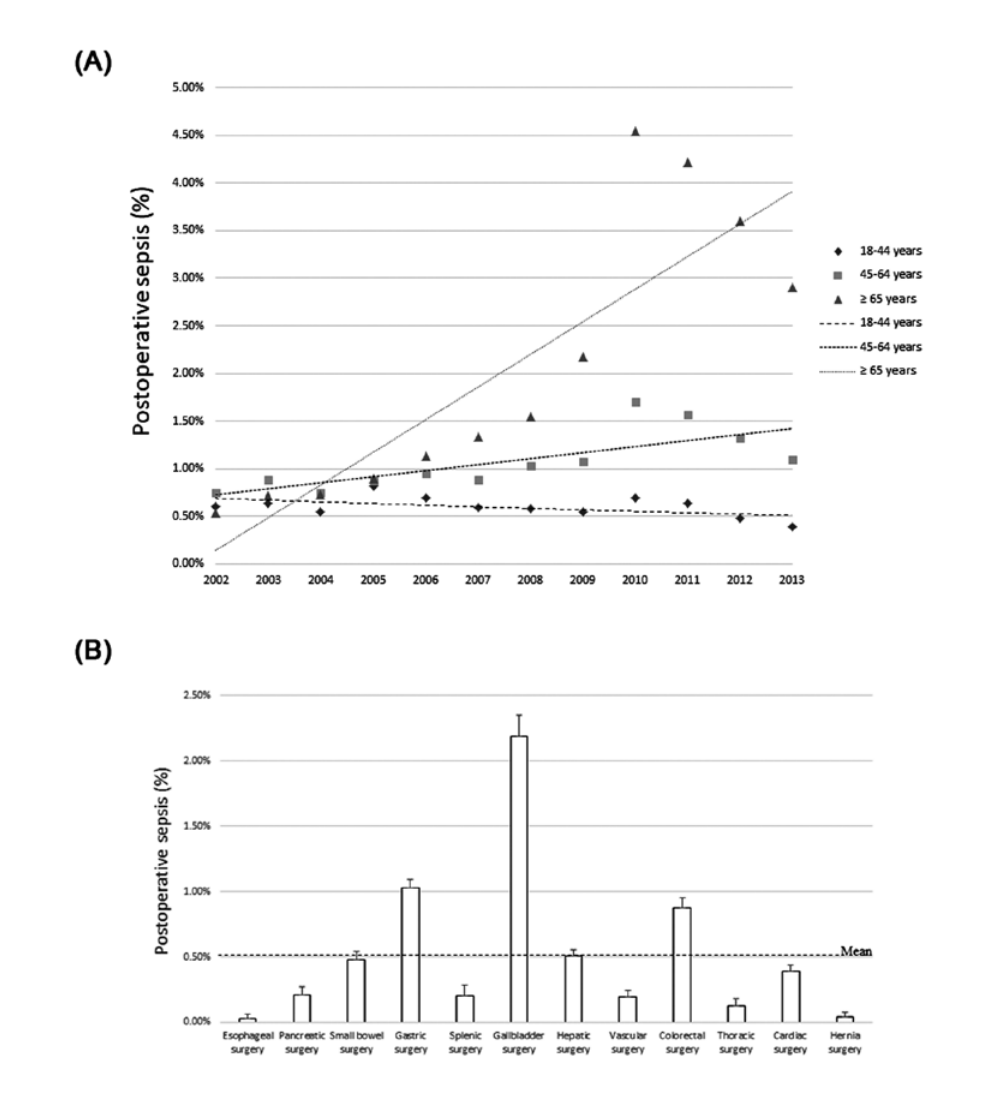
Figure 2: (A) Incidence of postoperative sepsis by age group (B) Incidence of postoperative sepsis by surgery